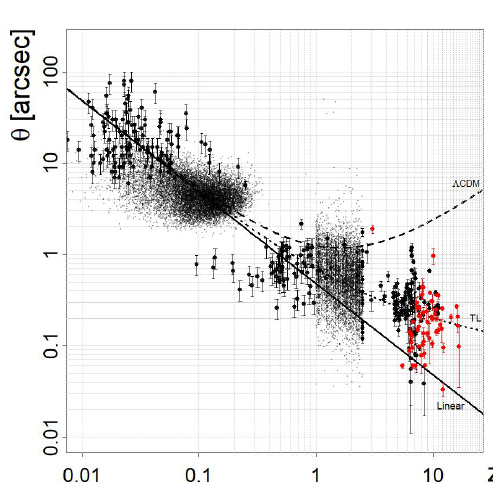
Figure 5. Angular diameters of a 10-kpc-size object as expected to be seen at different redshifts within the frameworks of Λ CDM (dashed curve) and of the non-expanding Universe model, TL (dotted curve). These expectations are compared with the actual angular sizes found in the recent JWST observations (red points) and some pre-JWST observations (black points). The solid curve indicates the simplest linear function for angular diameters based on the Hubble constant H 0